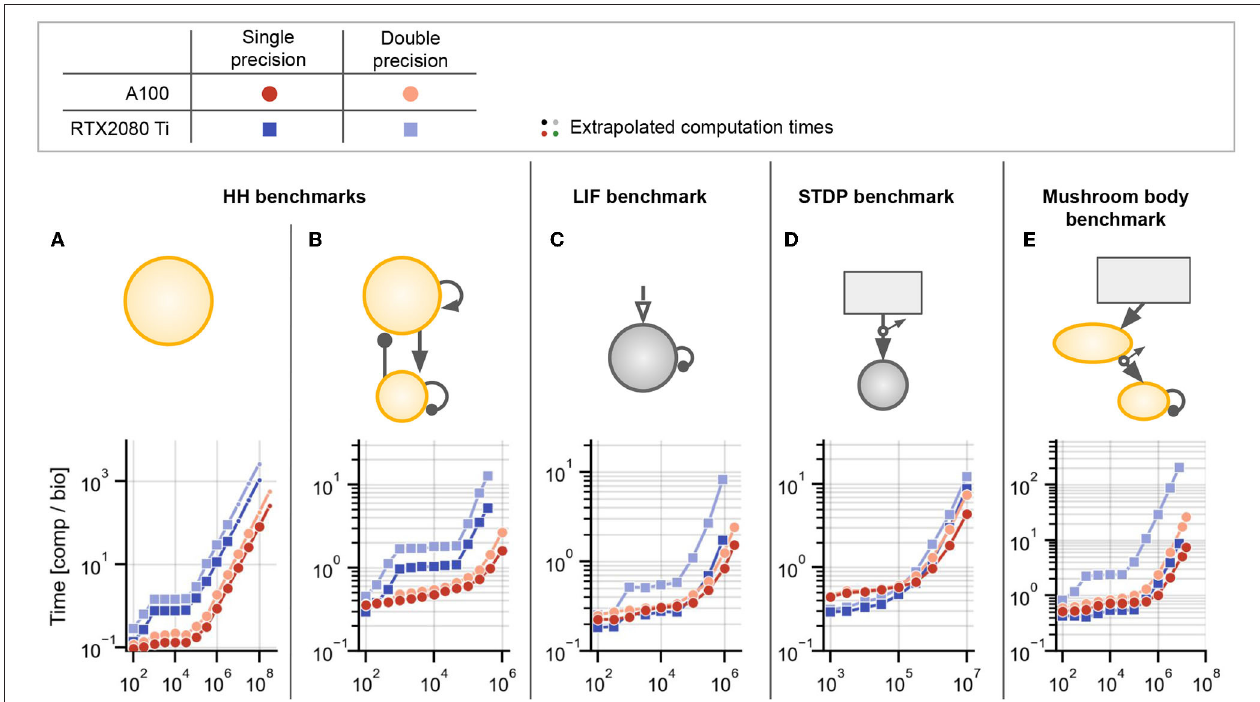
FIGURE 9 | Benchmark results for single- vs. double precision on consumer-grade vs. data-center GPUs. (A–E) Same benchmarks as shown in Figure 5 . Simulated without connectivity matrix partitioning in Brian2CUDA, with single-precision floats (dark colors) and double-precision floats (bright colors) and on A100 data-center GPUs (red colors) and GeForce RTX2080 Ti consumer-grade GPUs (blue colors). Dark red lines show same data as in Figure 5